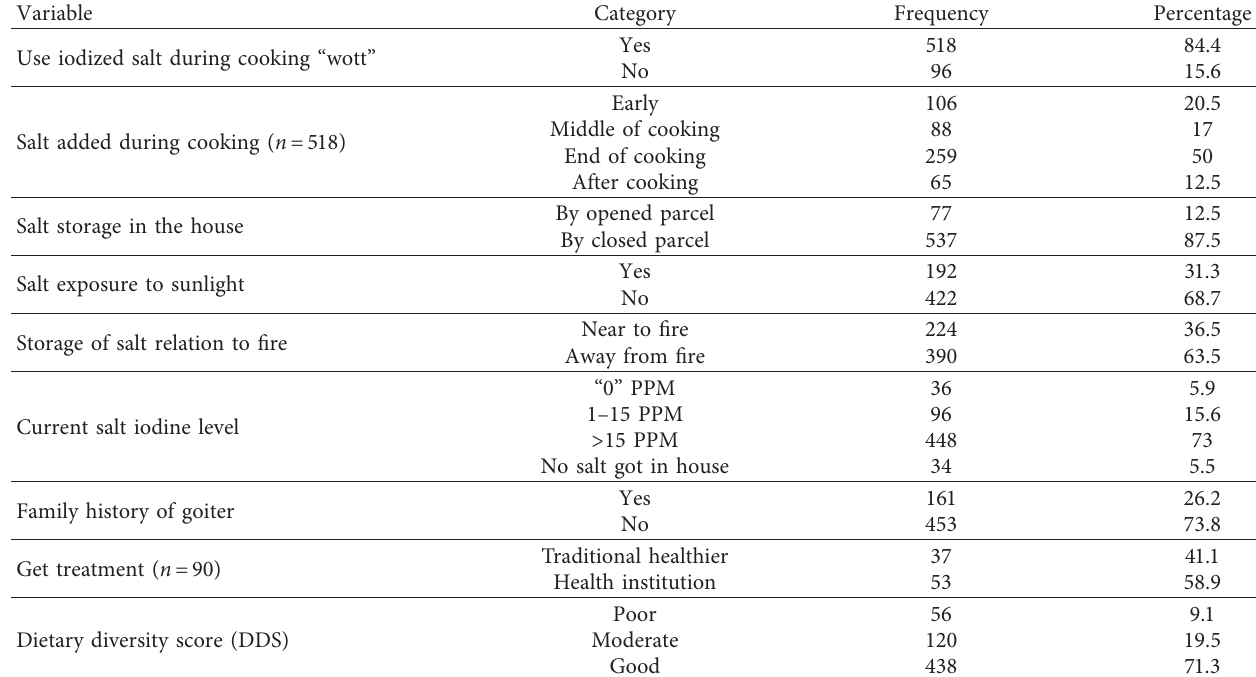
Table 2: Utilization of iodized salt and dietary practice-related characteristics of adolescent girls in Tach Armachiho district, Northwest Ethiopia, 2018 ( N �